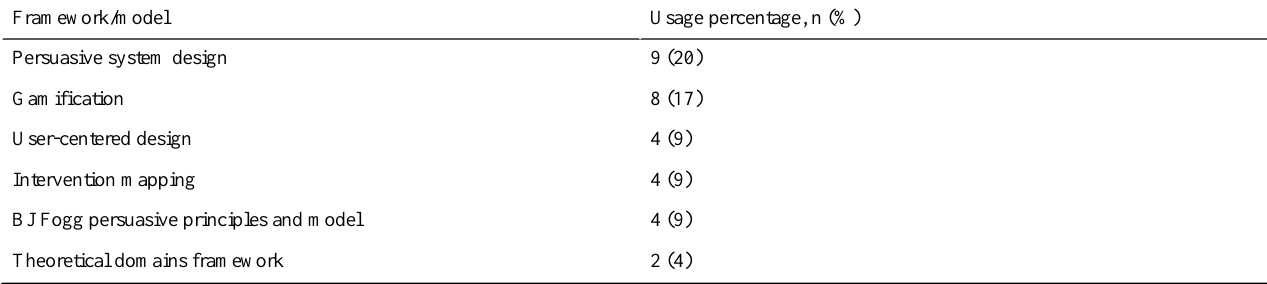
Table 9. Usage of different development framework/models